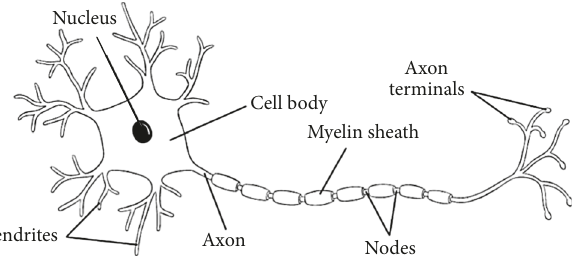
Figure 1: An example of mammalian neuron (modified from